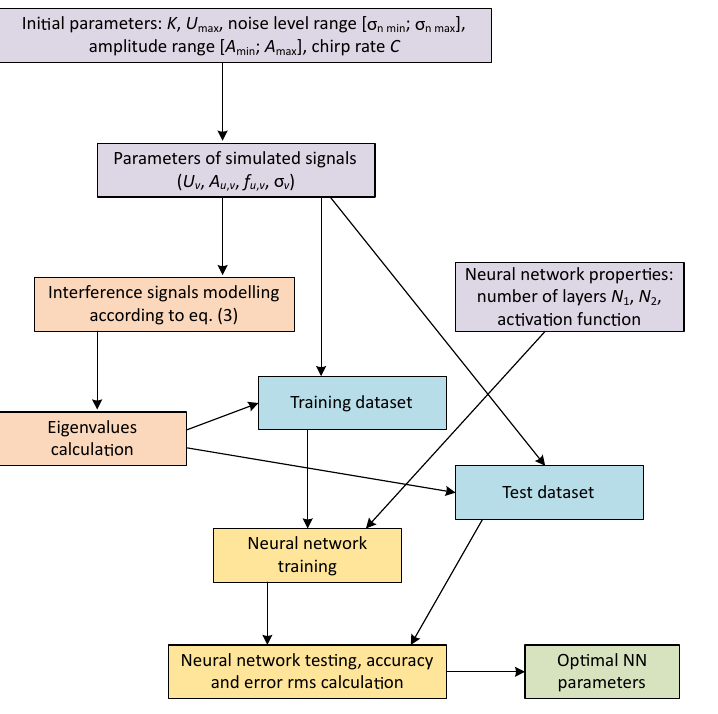
Figure 1. Flowchart of NN training for number of interference components estimation. Table 1. NN accuracy on test dataset for different numbers of neurons in first and second layer in case of sigmoid activation function (higher values correspond to better performance).